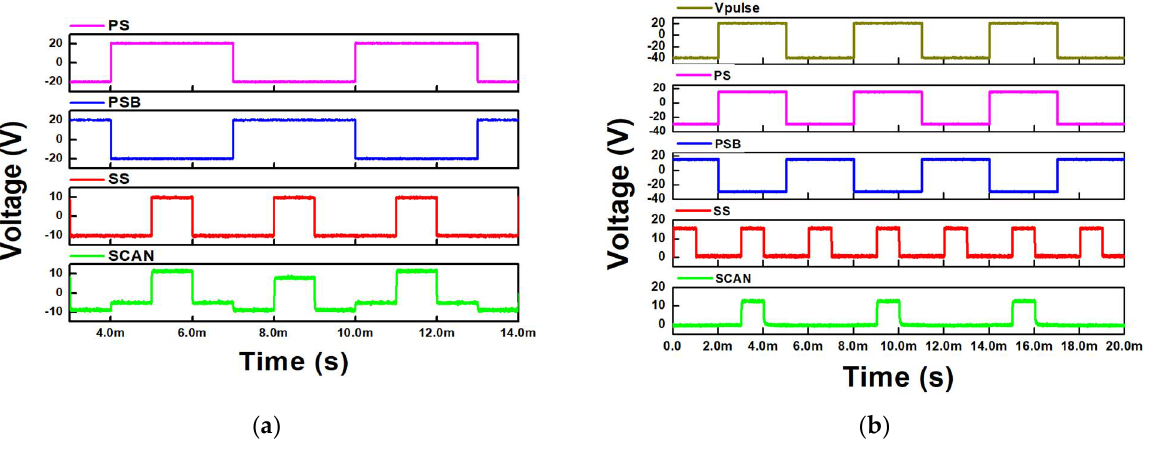
Figure 15. Measured waveforms of the fabricated single-stage drive circuits with the TFTs shown in Figure 14: ( a ) bootstrap scan driver; ( b ) modified bootstrap scan driver.